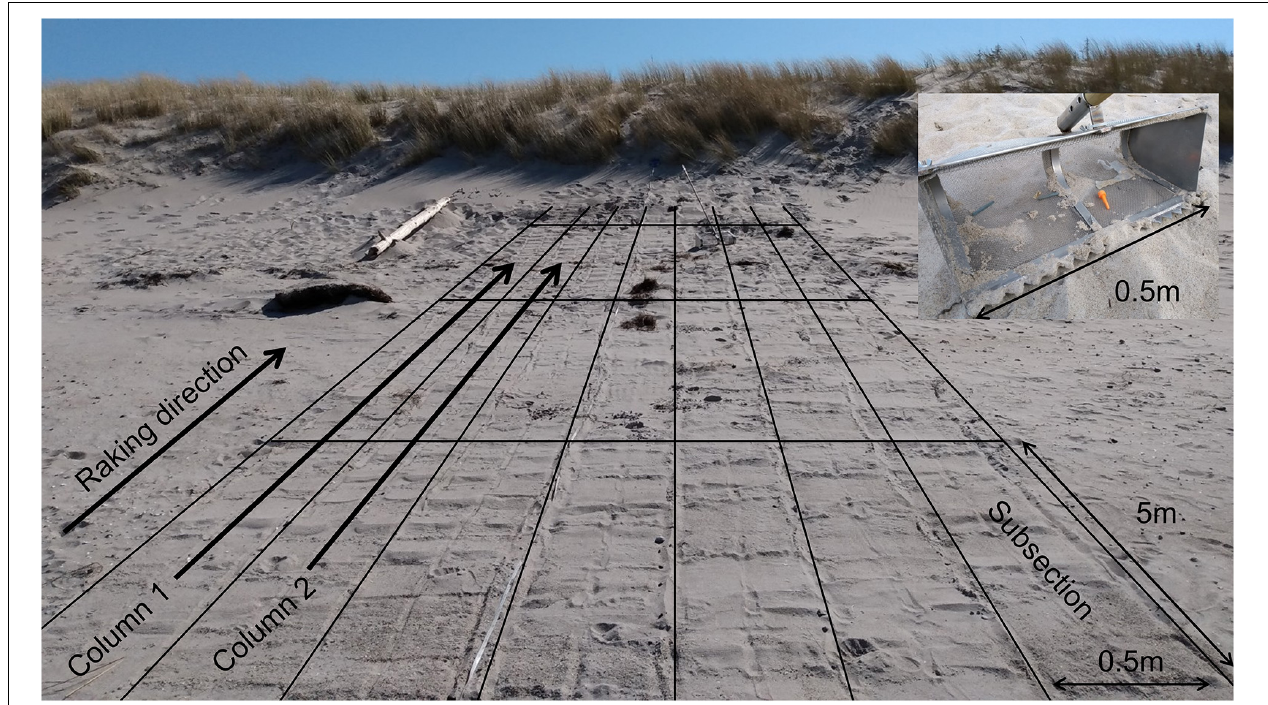
FIGURE 2 | Sand rake method survey on a sandy beach. Raking direction is from the waterline to the back of the beach (backshore). Operation width of the sand rake is 0.5m; the mesh size used is 2 mm. Each survey is divided in subsections of 0.5 m × 5 m resulting in an area of 2.5 m 2 . Subsections at the back of the beach may be smaller. One survey consists of one or more columns, with different number of subsections. The minimum area per survey is 50 m 2 .